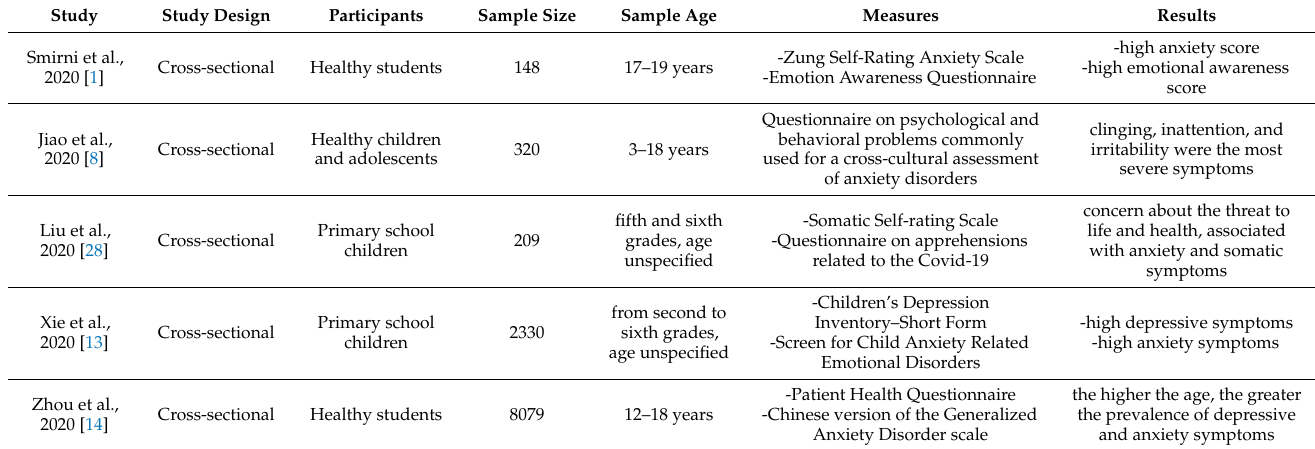
Table 2. Studies on the psychological impact on children and adolescents during